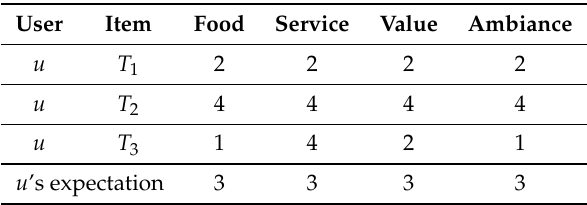
Table 2. Example of